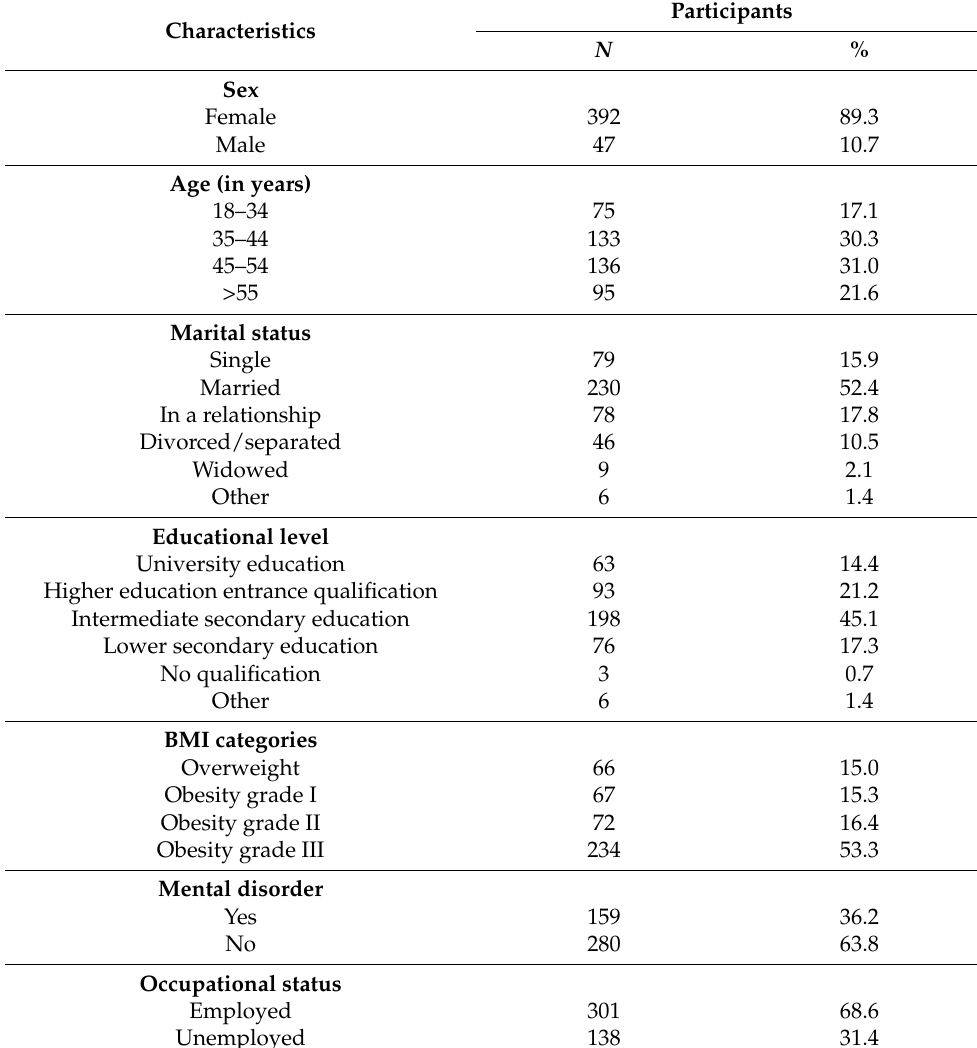
Table 1. Sociodemographic and medical